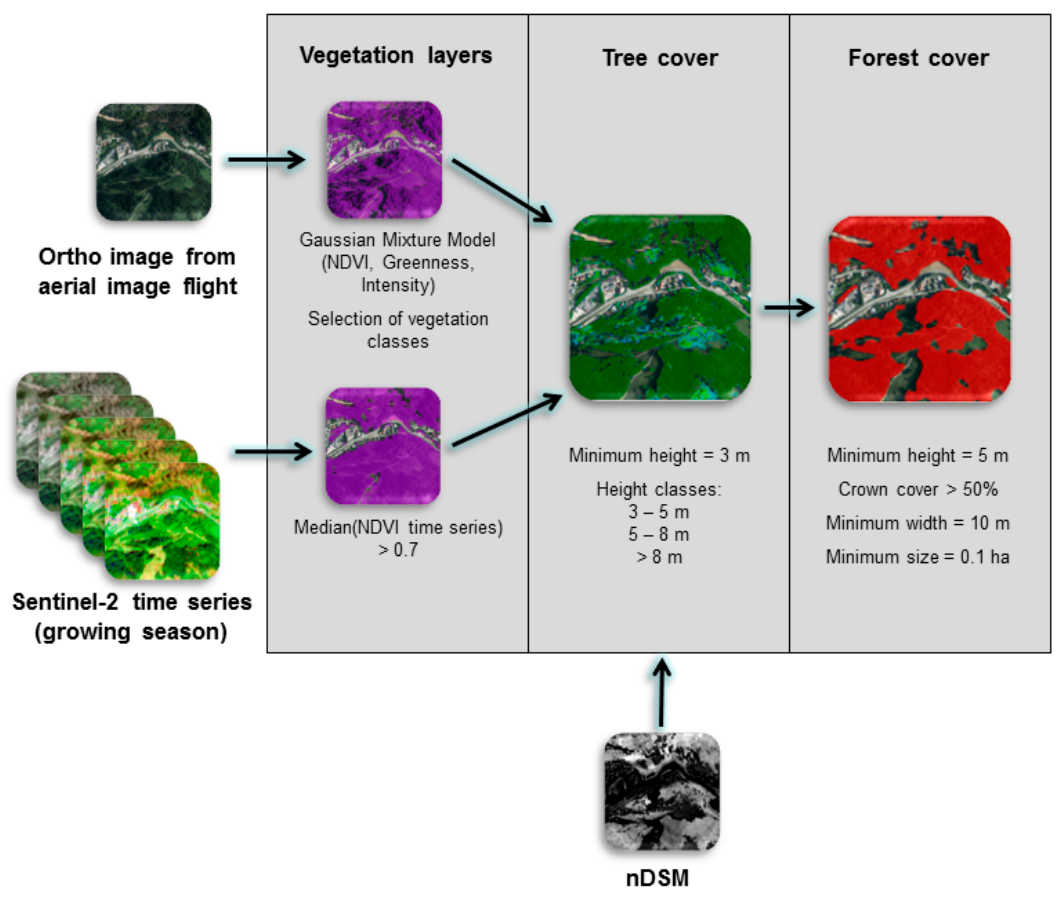
Figure 4. Calculation of the forest cover map. From both orthoimages and Sentinel-2 time series, a vegetation layer was built. By combining vegetation layers with nDSM, the tree cover layer was created. Forest cover is defined by the German NFI forest definition.